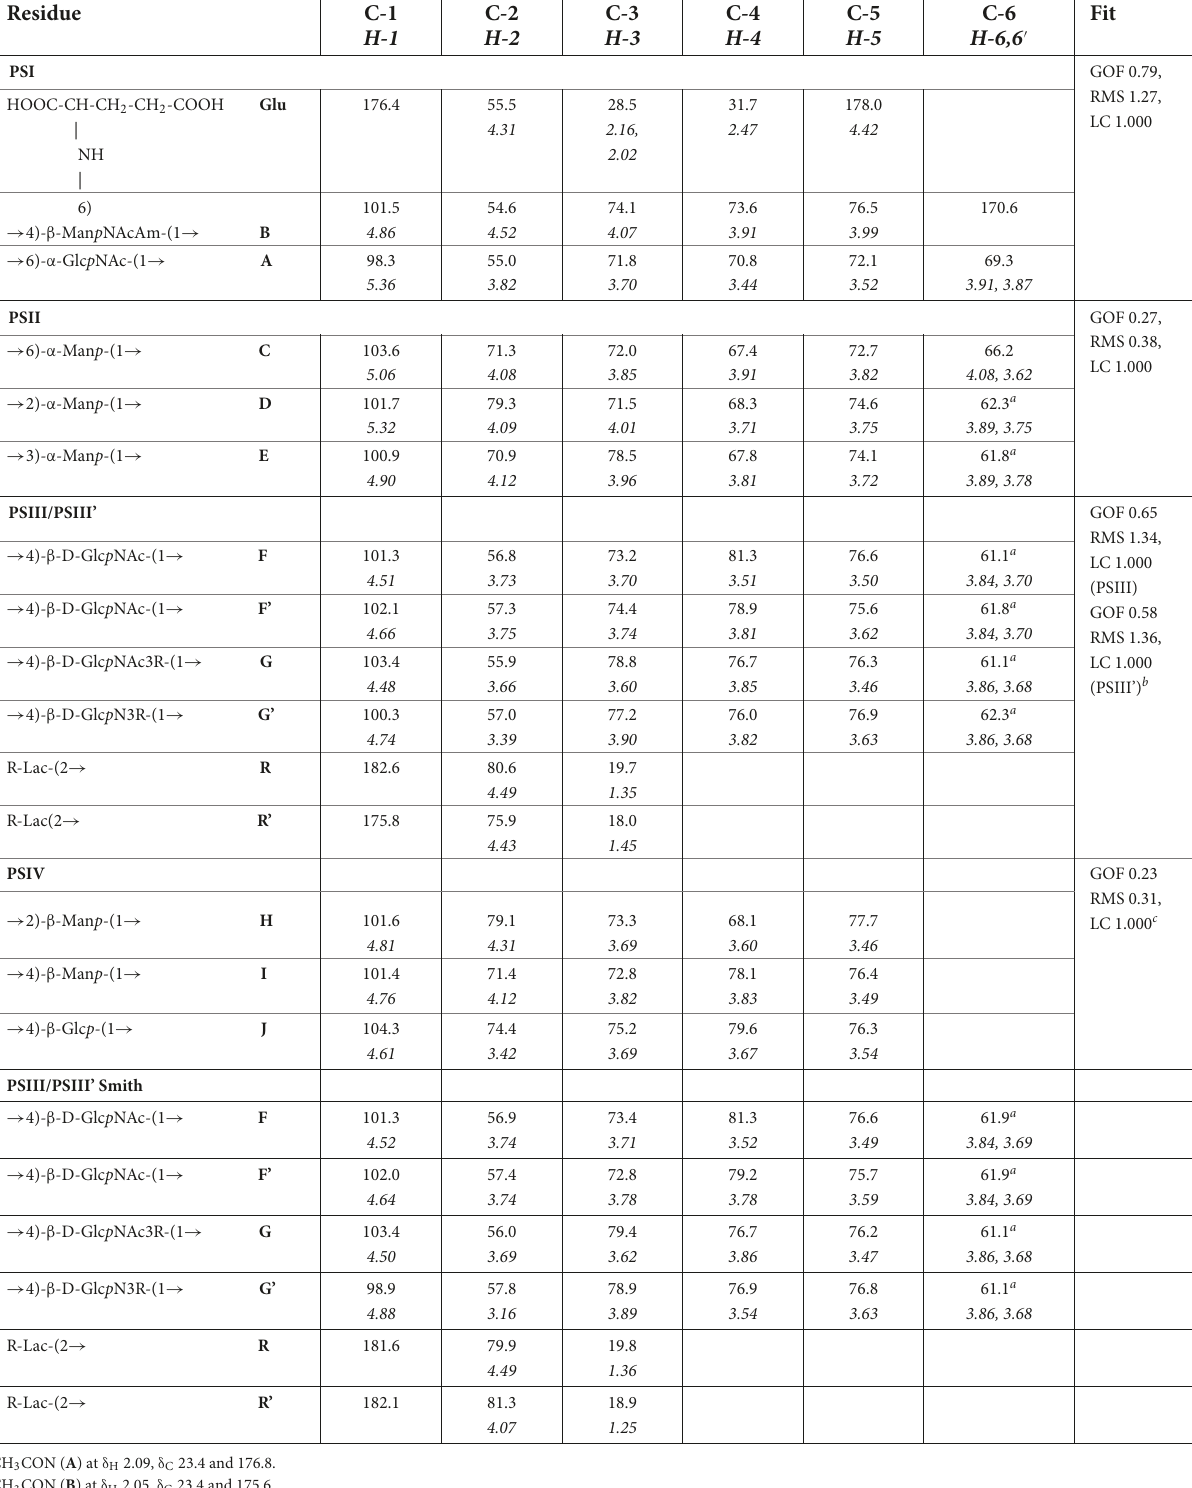
TABLE 5 1 H and 13 C NMR chemical shifts in cell wall polysaccharides of M. luteus C01 ( δ , ppm).